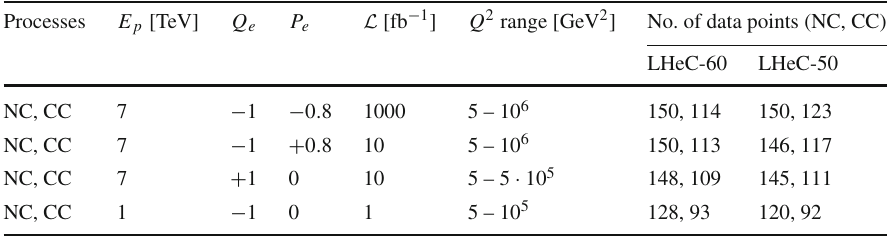
Table 2 Summary of the assumptions for uncertainties from various sources used in the simulation of the NC and CC cross sections. The first three items are calibration uncertainties and affect the event reconstruction. The last four items are uncertainties which can be assigned directly to the cross section